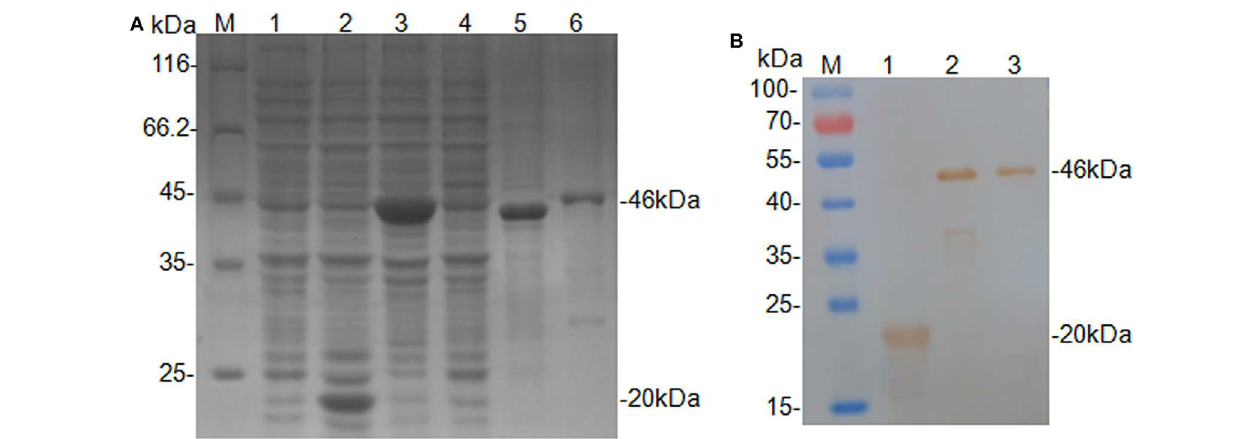
FIGURE 1 | Expression and identification of the rCap fusion protein. (A) SDS-PAGE analysis: Lane M, protein molecular weight marker; Lane 1, Rosetta control; Lane 2, pET-32a vector control; Lane 3, pET-32a-cap bacterial lysate; Lane 4, supernatant from pET-32a-cap bacterial lysate; Lane 5, the pellet of pET-32a-cap bacterial lysate; Lane 6, purified fusion protein. (B) Western blot analysis: Lane M, protein molecular weight marker; Lane 1, pET-32a vector control; Lane 2, pET-32a-cap bacterial lysate; Lane 3, purified fusion protein.